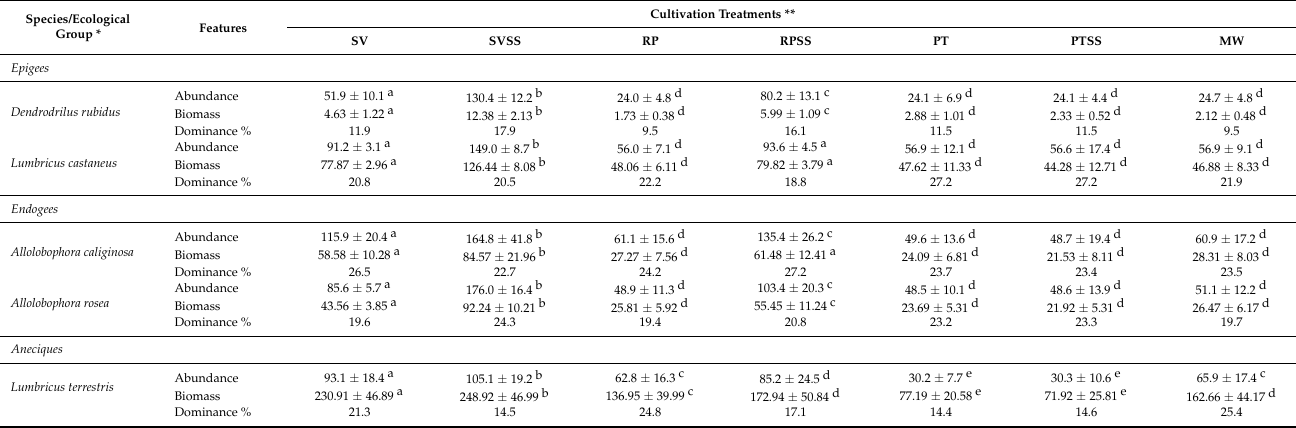
Table 2. Mean abundance (ind. m − 2 ), mean sum of biomass (g m − 2 ), and dominance of earthworm species found in the cultivation